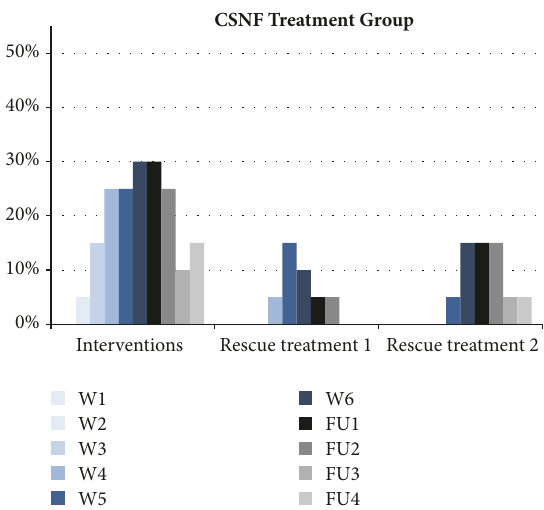
Figure 3: Interventions(wound smears and compresses) and rescue treatment 1 (Ialugen (cid:2) cream) and rescue treatment 2 (Ialugen plus cream) in the CSNF treatment group. The denominator is count of patients in the regarding population (CSNF group: n=20; standard reference treatment group: n=100). W: week; FU: follow-up.